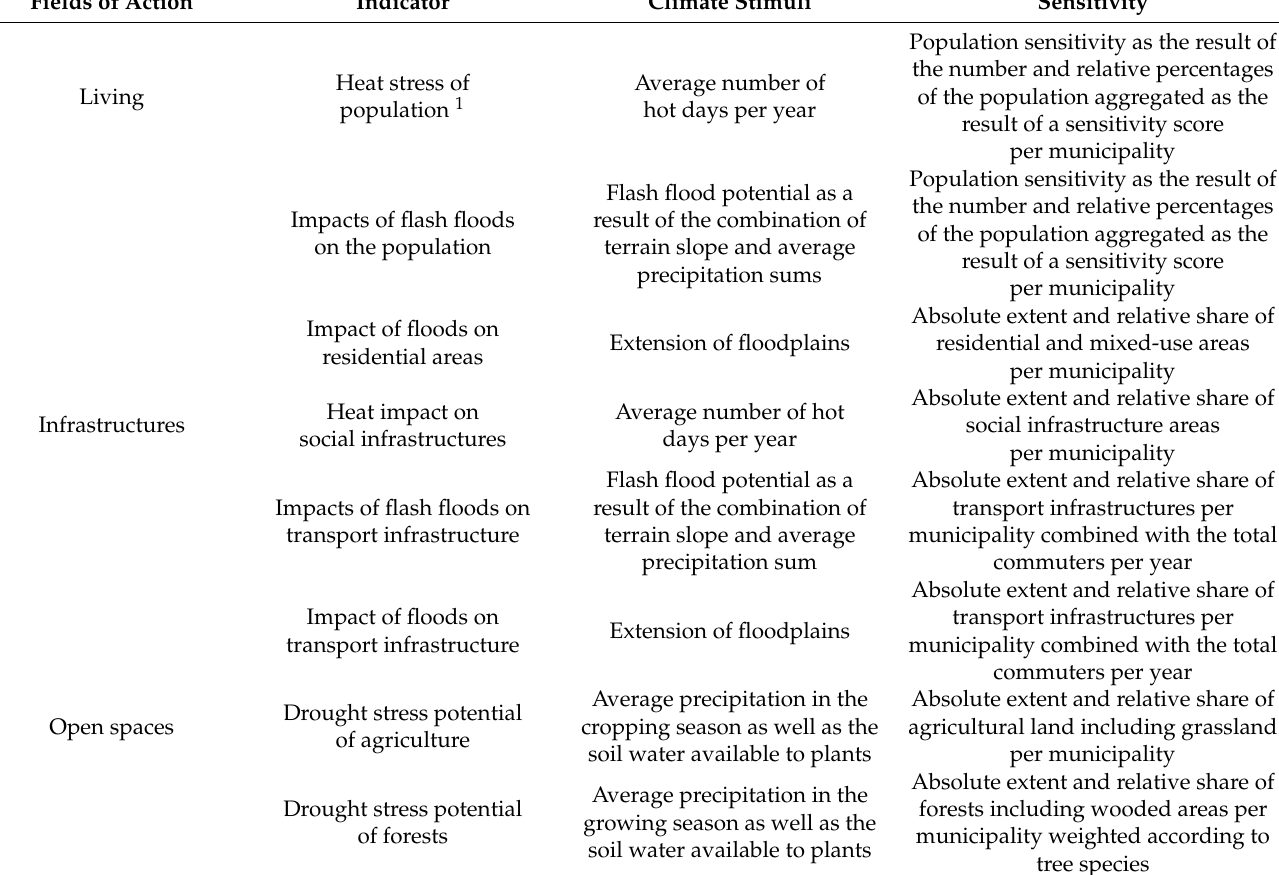
Table 1. Overview of indicators, their field of action and the used sub-indicators for climate stimuli and sensitivity within the CIA for the Rhenish lignite-mining